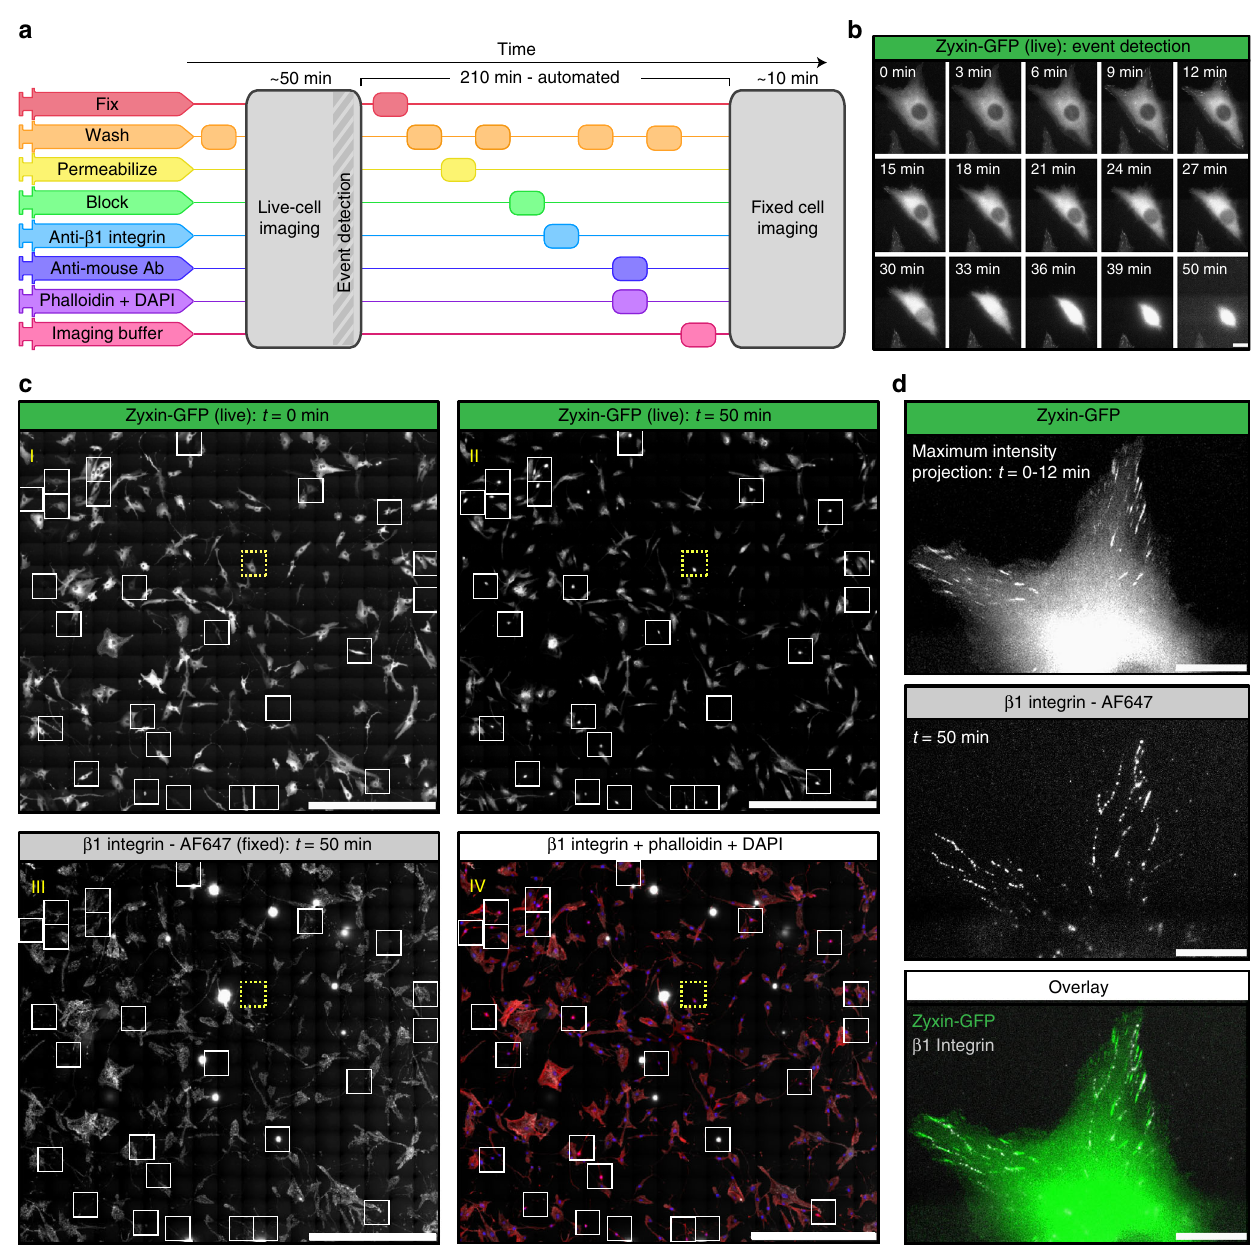
Fig. 2 Event-driven fi xation of cells upon mitotic rounding. a NanoJ-Fluidics work fl ow of the event-driven protocol performed. b Stills of RPE1 zyxin-GFP live- cell timelapse during mitotic rounding. Scale bar, 20 μ m. c Stitched mosaic (17 × 17 individual regions) of: I — First frame of the live-cell timelapse; II — Last frame of the live-cell timelapse; III — RPE1 zyxin-GFP cells immunolabelled for active β 1-integrin; IV — Overlay of RPE1 zyxin-GFP cells immunolabelled for active β 1-integrin and stained for F-actin (with phalloidin-TRITC) and DNA (with DAPI). White boxes represent cells where mitotic rounding was observed (Supplementary Movie 4), yellow dashed inset is the cell in ( b ) and ( d ). Scale bar is 1 mm. d I — Maximum intensity projection of the fi rst 12 min in ( b ); II — Active β 1-integrin staining; III — Overlay of both panels. Scale bar, 20 μ